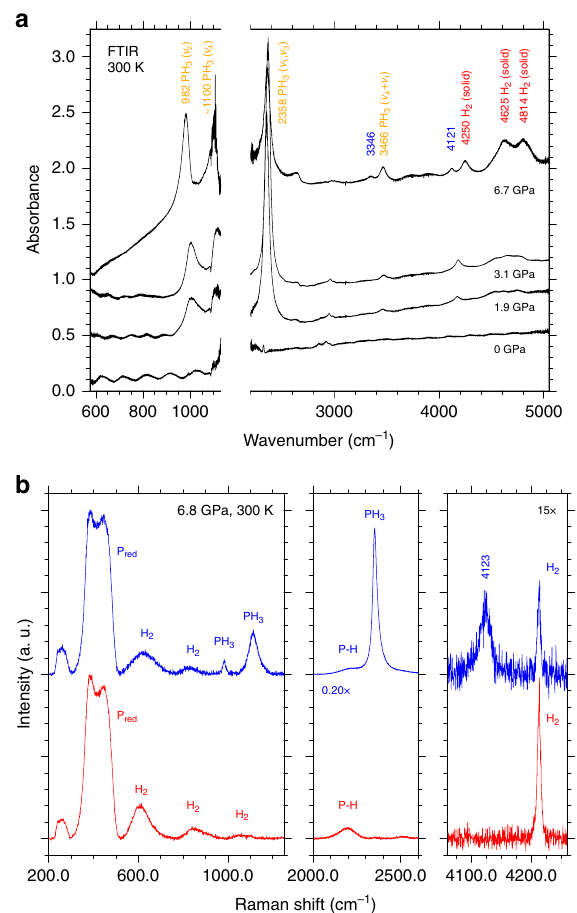
Fig. 3 FTIR and Raman spectroscopy. a Room T FTIR absorption spectra of the sample acquired at 6.7 GPa after LH3 and at different pressure values during decompression to ambient conditions. The two bands at 3346 and 4121 cm − 1 labeled in blue disappear on releasing pressure to 3.1 GPa. The spectra have been vertically translated for clarity and the values on the absorbance scale are intended for relative comparison. The break on the wavenumber axis excludes the spectral range corresponding to the Ia diamond saturating absorptions, which partially covers the ν 4 absorption of PH 3 . The absorption features at ~2640 cm − 1 (6.7 GPa) and ~2900 cm − 1 (appearing on releasing pressure to 3.1 GPa) are assigned respectively to the diamond from the ambient pressure reference and to traces of oil on the optics of the interferometer. b Signi fi cant spectral regions of type-1 (red, lower trace) and type-2 (blue, upper trace) Raman spectra acquired on different selected spots of the mapping grid across the sample at 6.8 GPa and room T after LH. With respect to type-1 spectrum the type-2 one clearly shows the simultaneous presence of PH 3 and of the extra band at 4123 cm − 1 in the H 2 stretching region at lower frequency compared to pure H 2 at 983, ~1100 (out of scale) 2358, 3346, 3466, 4121, 4250, 4625, and 4814 cm − 1 .